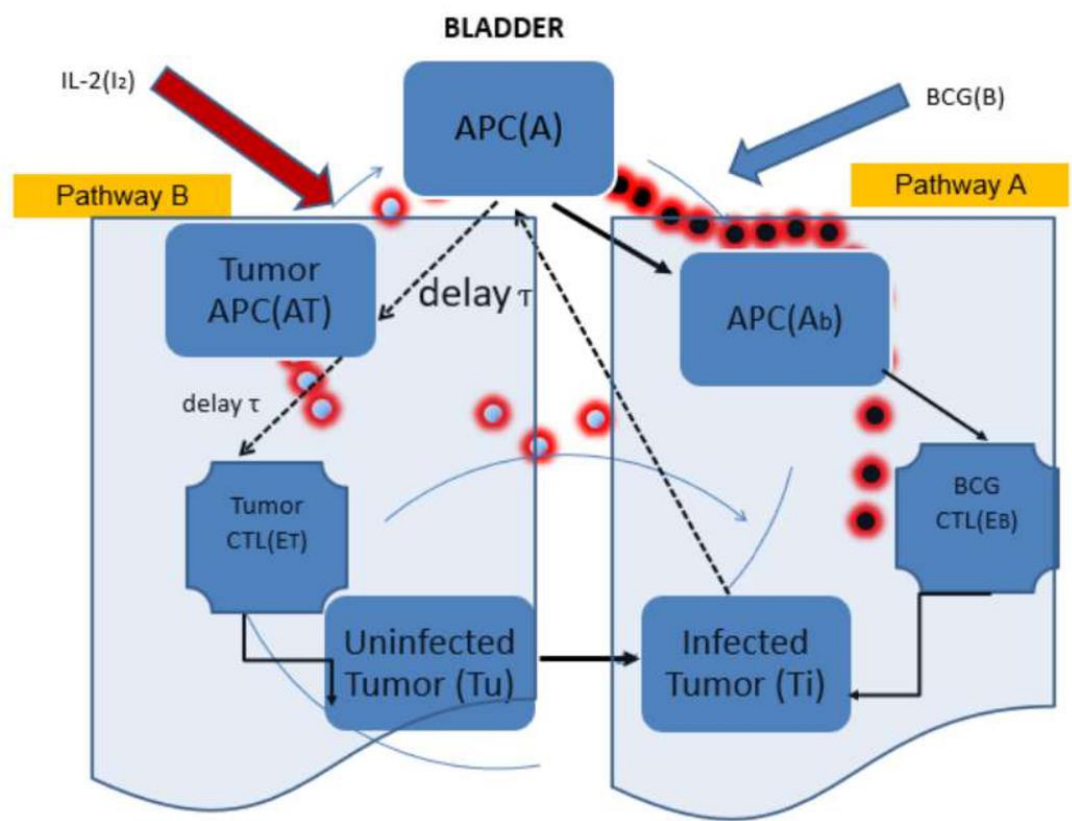
Figure 1. BCG (denoted by B) invade the APCs (denoted by A) present ed in the urothelium. Bacterial infection stimulates APCs to produce inflammatory cytokines such as IL-2. At the same time, bacteria infect residual cancer cells after surgery designated as T u . As a result of infection, bacterial Ag appears on the surface of tumor cells, attracting APC (designated as A B ). A B engulf tumor infected cells ( T i ) and transfer the tumor agent to APC (denoted by A T ). Due to the inflammatory environment created by the bacterial infection, A B cause CTLs to either mature and track bacterial Ag, denoted as E B (Pathway A), or mature and invade tumor cells according to their tumor Ag, starting with a delay τ (it is indicated by a broken line) due to the time it takes to form the CTL population, designated by E B (Pathway B). Two CTL populations can destroy tumor cells E B and E T ; and IL-2 will stimulate the maturation of the CTL cell